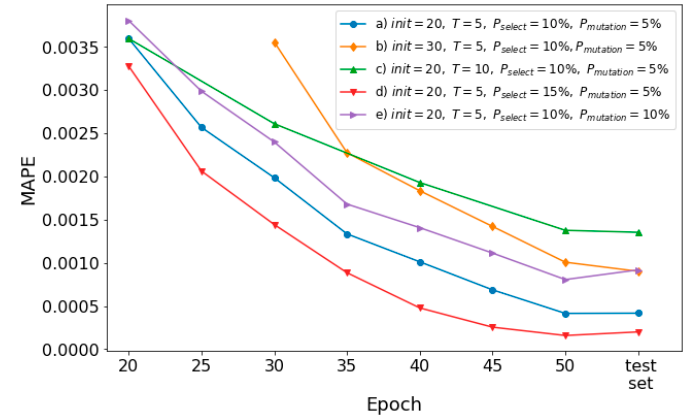
Figure 9. The impact of evolutionary parameters on model performance.